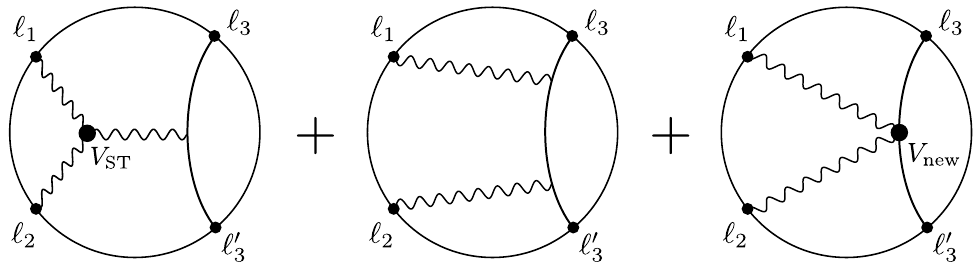
Figure 4 . The bulk diagrams that describe the correlator h j 1 j 2 O 3 i of two local boundary currents and one bilocal. V is the Sleight-Taronna cubic vertex, while V ST two HS fields to a DV particle’s worldline. We argue that the non-localities in V ∼ 1 AdS